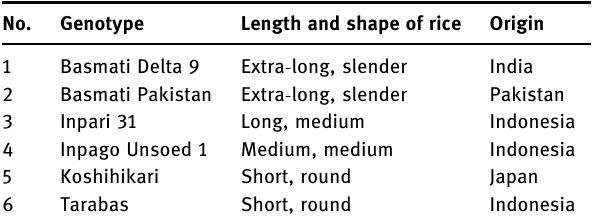
Table 1: Six rice genotypes used for diallel mating